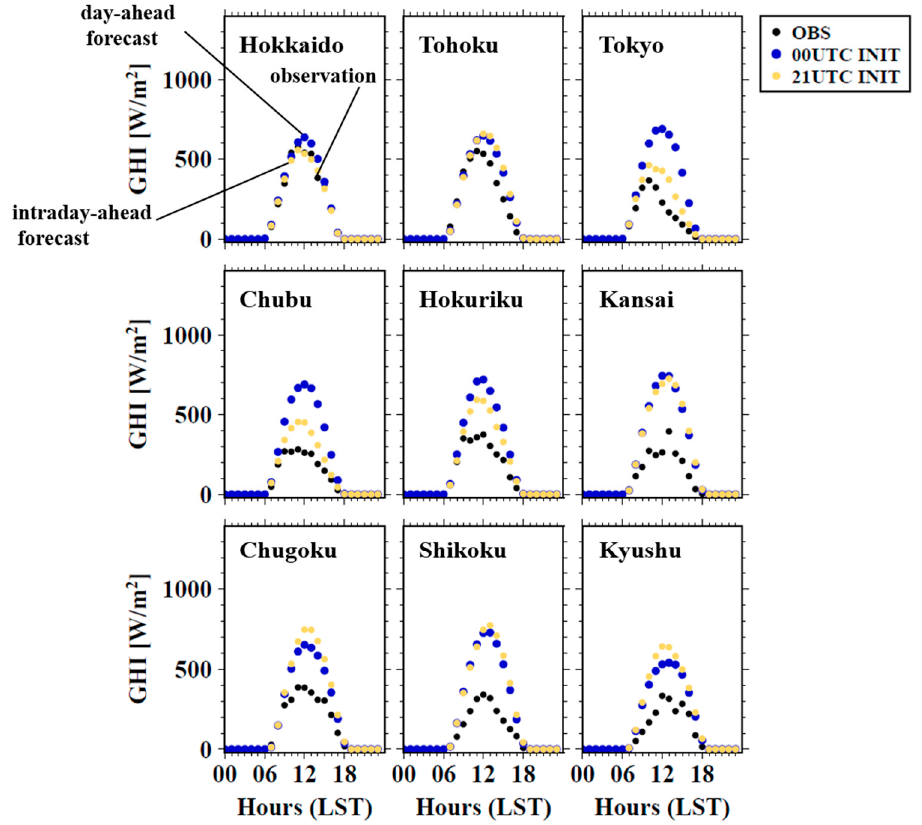
Figure 7. Same as Figure 4, but for 10 October 2015.